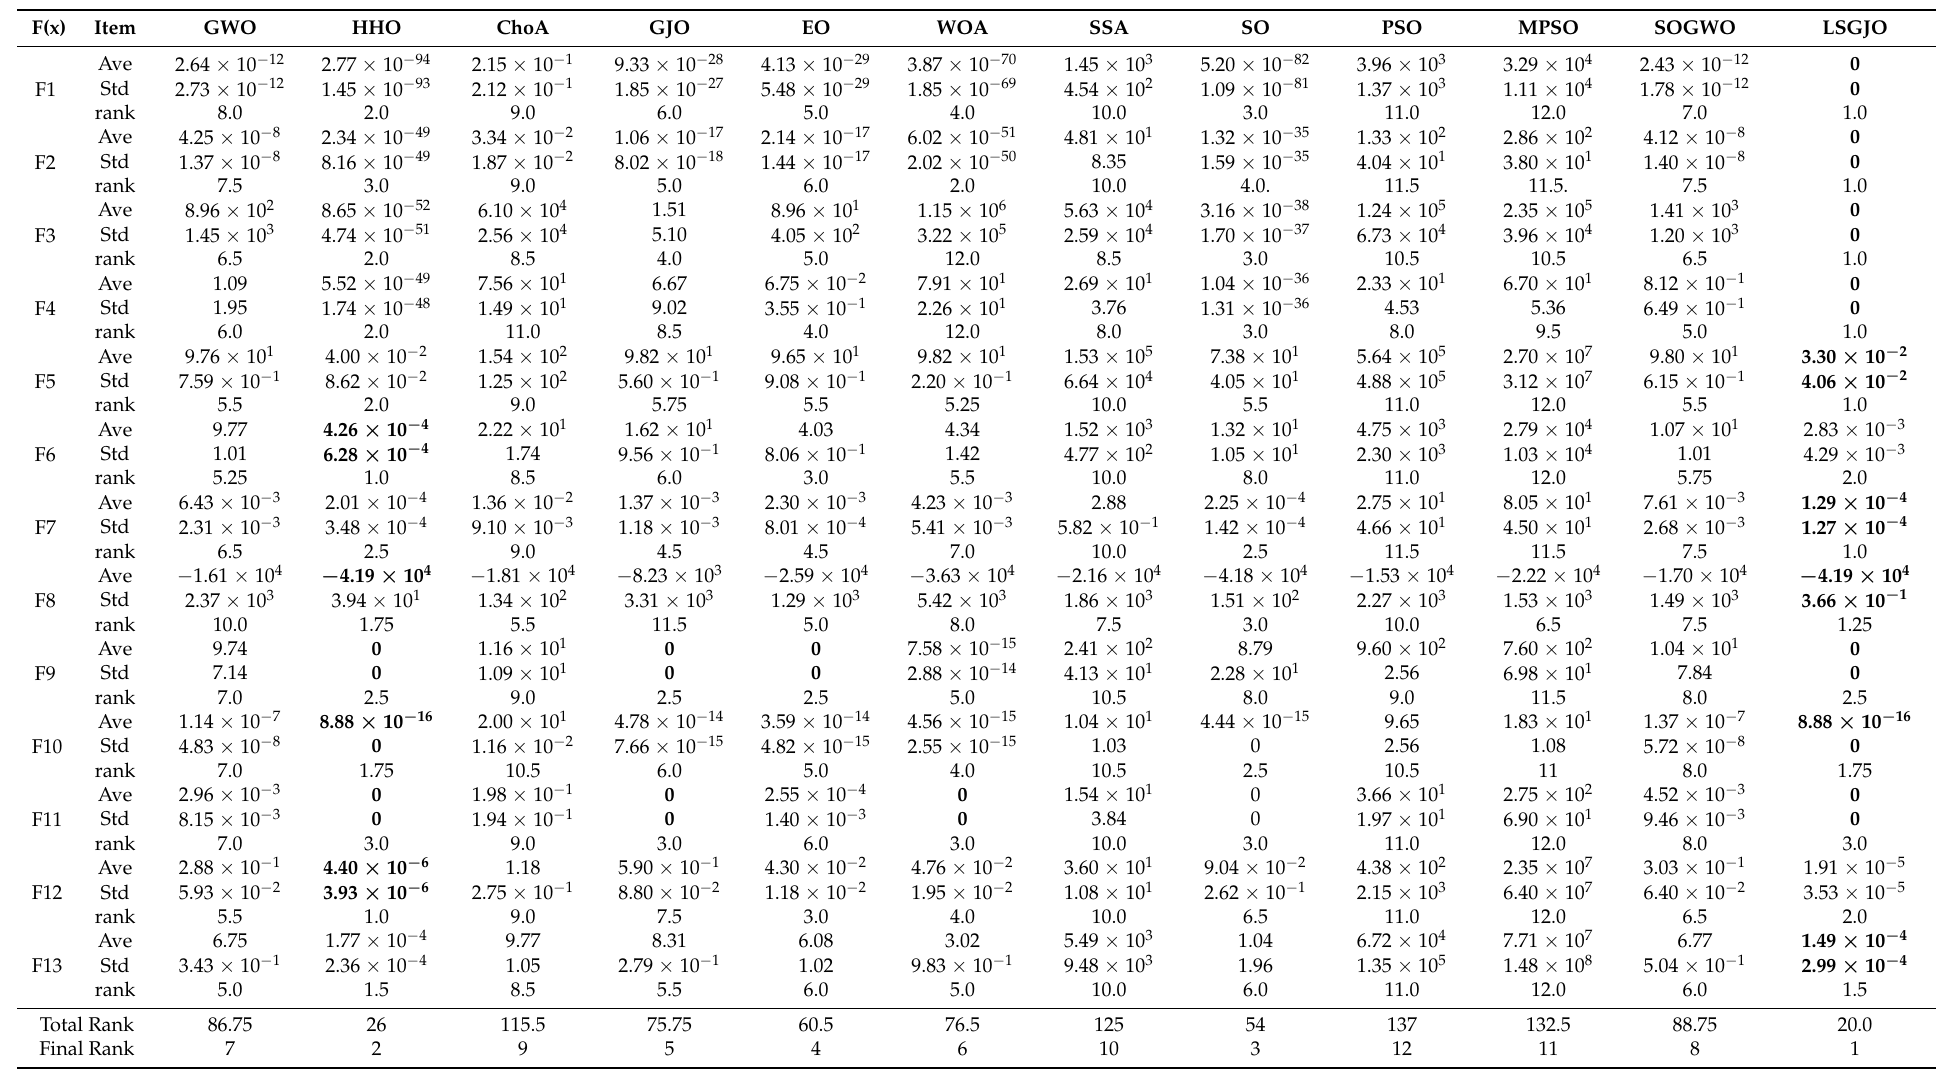
Table 4. Results and comparison of different algorithms on 13 benchmark functions with Dim = 100. The best results of the experiments are shown in